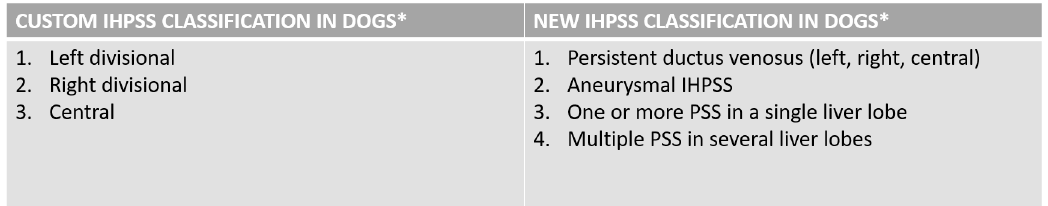
Figure 10. On the left, current classification of intrahepatic portosystemic shunt in dogs [54–56]. On the right, the new classification proposal. Four different phenotypes are possible. The persistent ductus venosus is the most commonly encountered IHPSS. It can be anatomically left, right or central located. Other complex IHPSS are increasingly recognized with CT and may involve one or more liver lobes, as already described in children